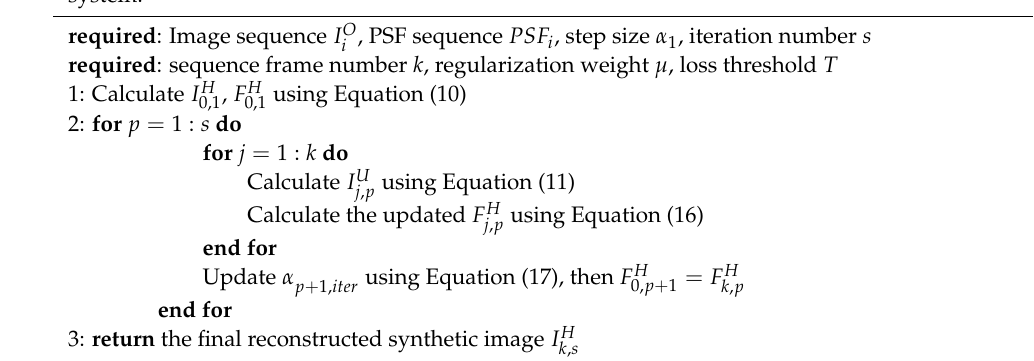
Algorithm 2 The image synthesis algorithm based on Fourier spectrum restoration for RRA